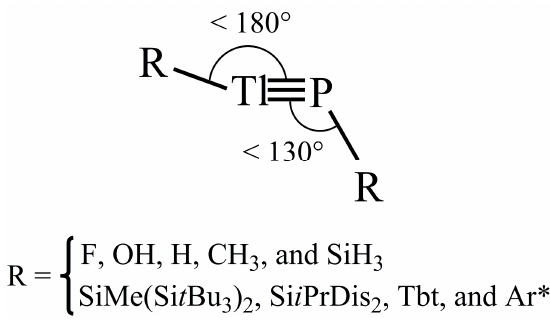
Figure 6. The predicted geometrical structure based on the present theoretical calculations.